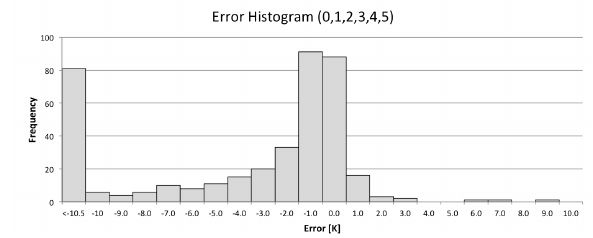
Figure 11: Histogram of error values for subset of Landsat 5 val- idation dataset processed using MERRA data.